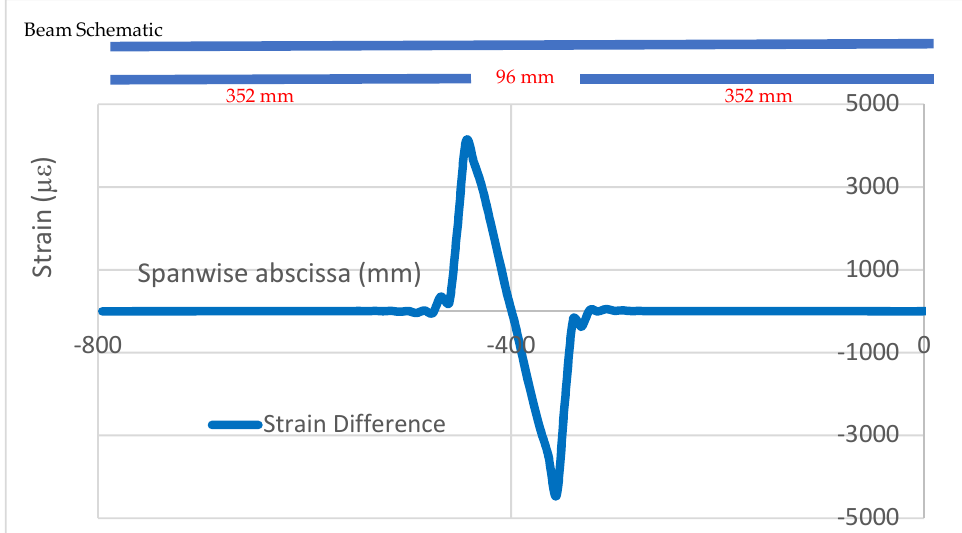
Figure 10. Strain profiles for locally de-bonded spar at the inner cap fiber.